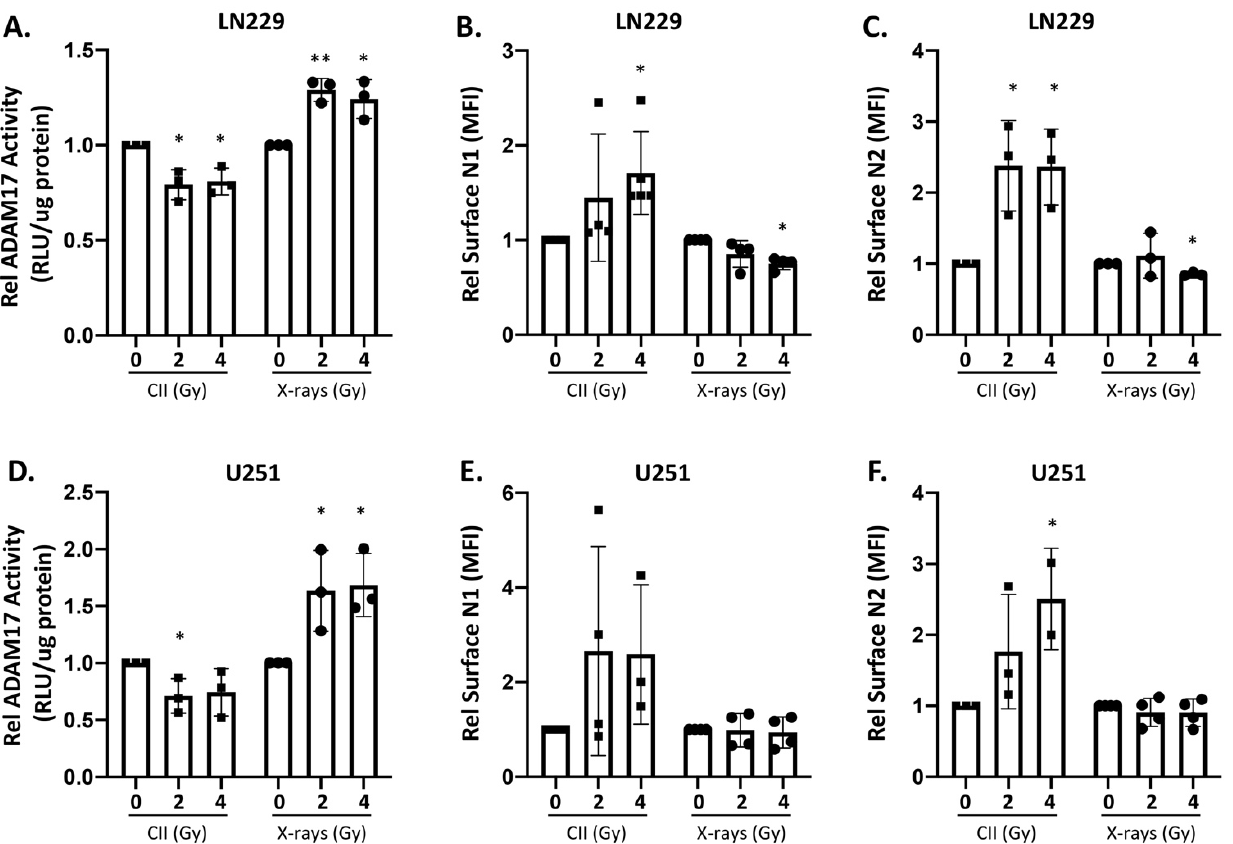
Figure 3. Differential regulation of ADAM17 activity and cell surface Notch receptors by CII and X-rays in human glioma cell lines: Relative ADAM17 activity at 24 h after irradiation with CII and X-rays in ( A ) LN229 and ( D ) U251 cells. Relative MFI of cell surface NOTCH1 receptor (N1) in ( B ) LN229 and ( E ) U251 and NOTCH2 receptor (N2) in ( C ) LN229 and ( F ) U251, as determined by flow cytometry at 24 h after irradiation with CII and X-rays. Each symbol represents an independent experiment. Data are presented as mean ± SD. Statistical analysis was performed by ANOVA with Bonferroni post-hoc test. p -values (* p < 0.05, ** p < 0.01).